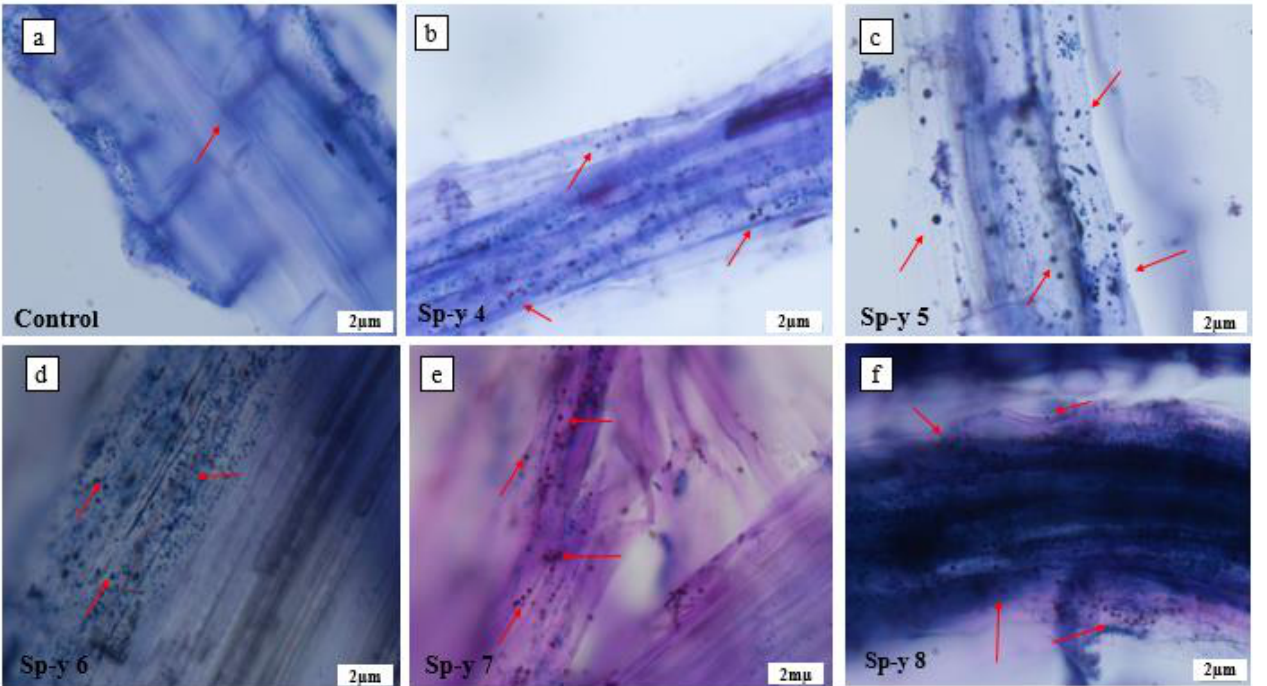
Figure 6. Microscopic images of root tissues of rice seedlings revealing presence of bacteria cells. ( a ) The root tissue of 10-day-old seedlings under the control treatment. ( b ) Visible presence of bacteria present in the root tissue of rice seedlings treated with SP-y 4; ( c ) Bacteria present in the root tissue of seedlings treated with SP-y 5; ( d ) Rice seedlings treated with SP-y 6 with high presence of the bacteria in the root tissue; ( e ) Root tissue of rice seedlings treated with SP-y 7; ( f ) Bacteria present in seedlings treated with SP-y 8.